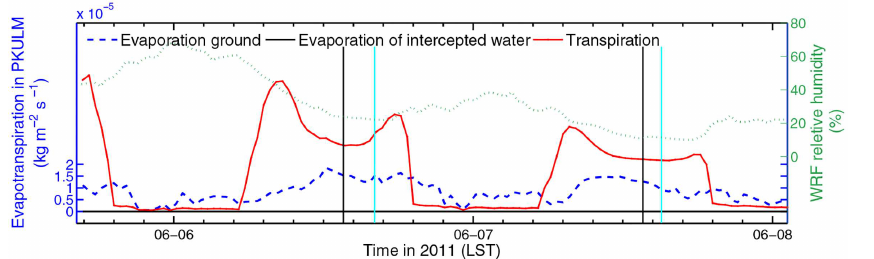
Fig 11. Similar to Fig 8, but in